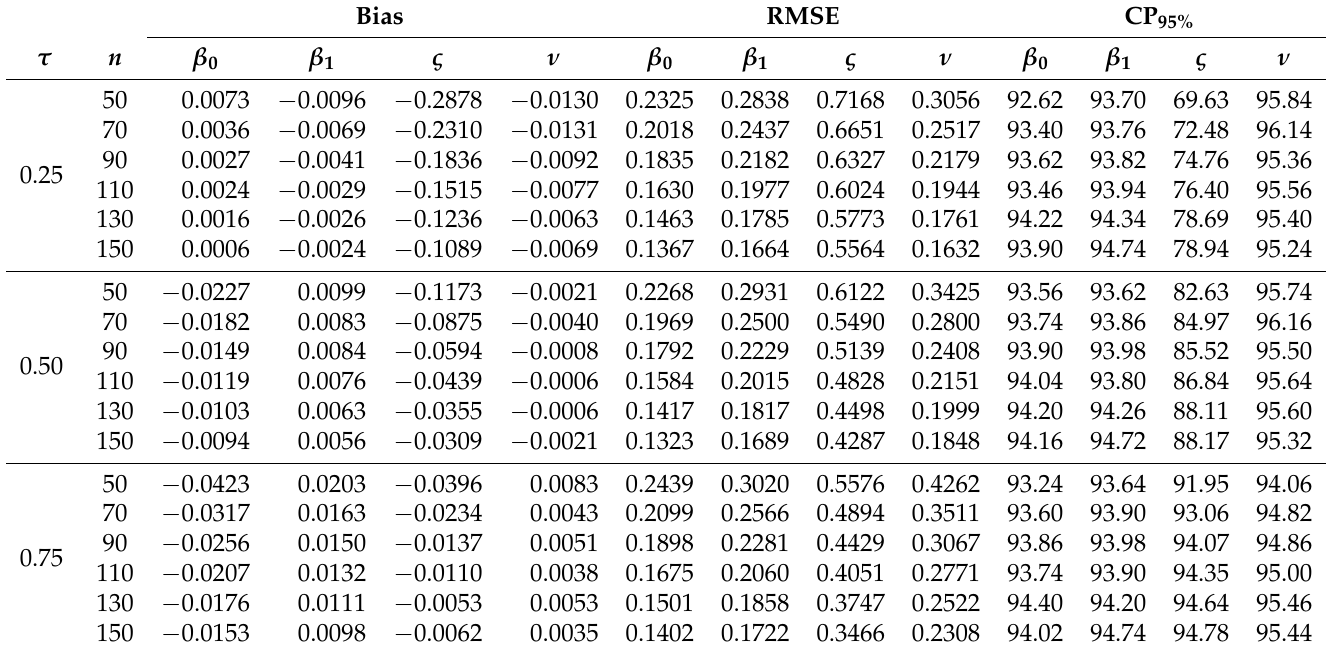
Table 7. Empirical RMSE, bias, and 95% CP (true values: β 0 = 0.50, β 1 = 0.50, ς = 1.50, and ν = 2.00) of the ML estimator for the indicated parameter with simulated data.